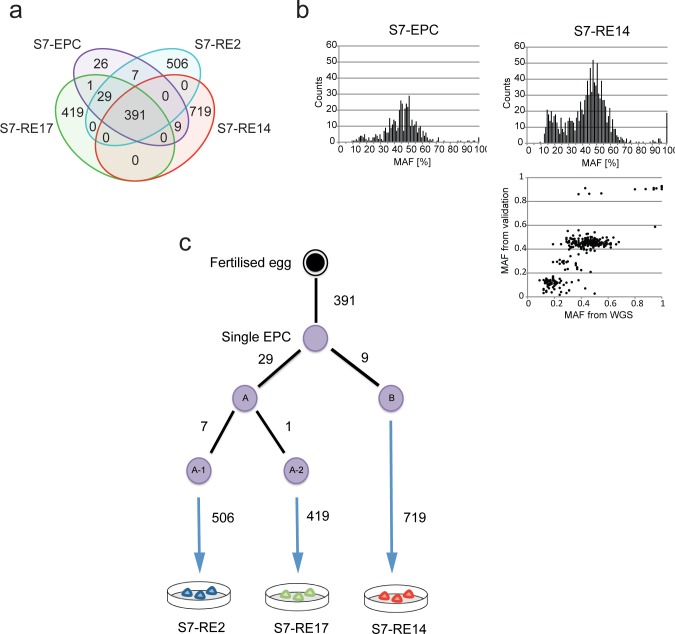
Whole genome sequencing and detailed analysis of iPSCs derived from a monoclonal somatic cell reveal lineage relationships in vitro.a. Venn diagram showing the overlap of mutations found in each cell line. b. Histogram showing mutant allele frequencies (MAF) of SNVs found in EPCs and S7-RE14. Note the presence of sub-clonal SNVs (<30% MAF). MAFs observed from amplicon resequencing revealed 3 distinct sub-populations, which represent clonal SNVs, SNVs fixed during the first and second cell division (bottom panel). c. Cellular phylogenetic tree showing the relationship between the first and second cell divisions of the originating EPC and the subsequent iPSC line. The minimum number of mutations (taking into account limitations of the sensitivity of detecting sub-clonal mutations by whole genome sequence) accrued by each daughter cell is shown.